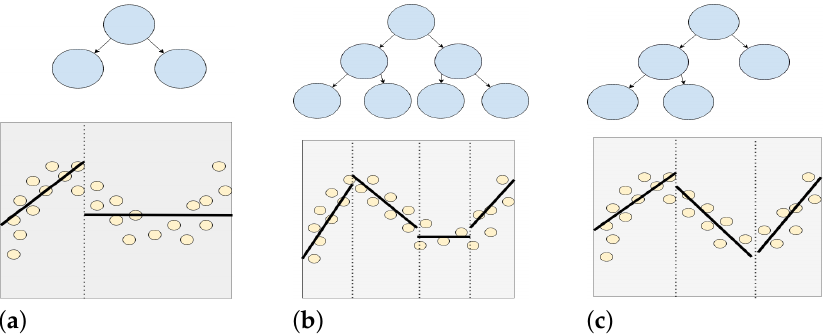
Figure 2. Illustrations of how two perfect LMTs of depth ( a ) two, ( b ) three, and ( c ) an imperfect LMT of depth three, fit to the same data set. The number of regions estimated by a linear function correspond to the number of leaf